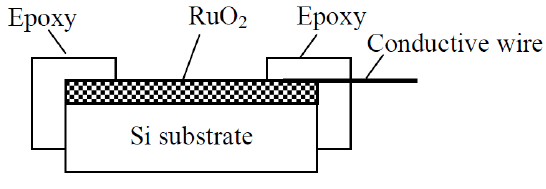
Figure 1. Cross-section of the ruthenium dioxide pH electrode.